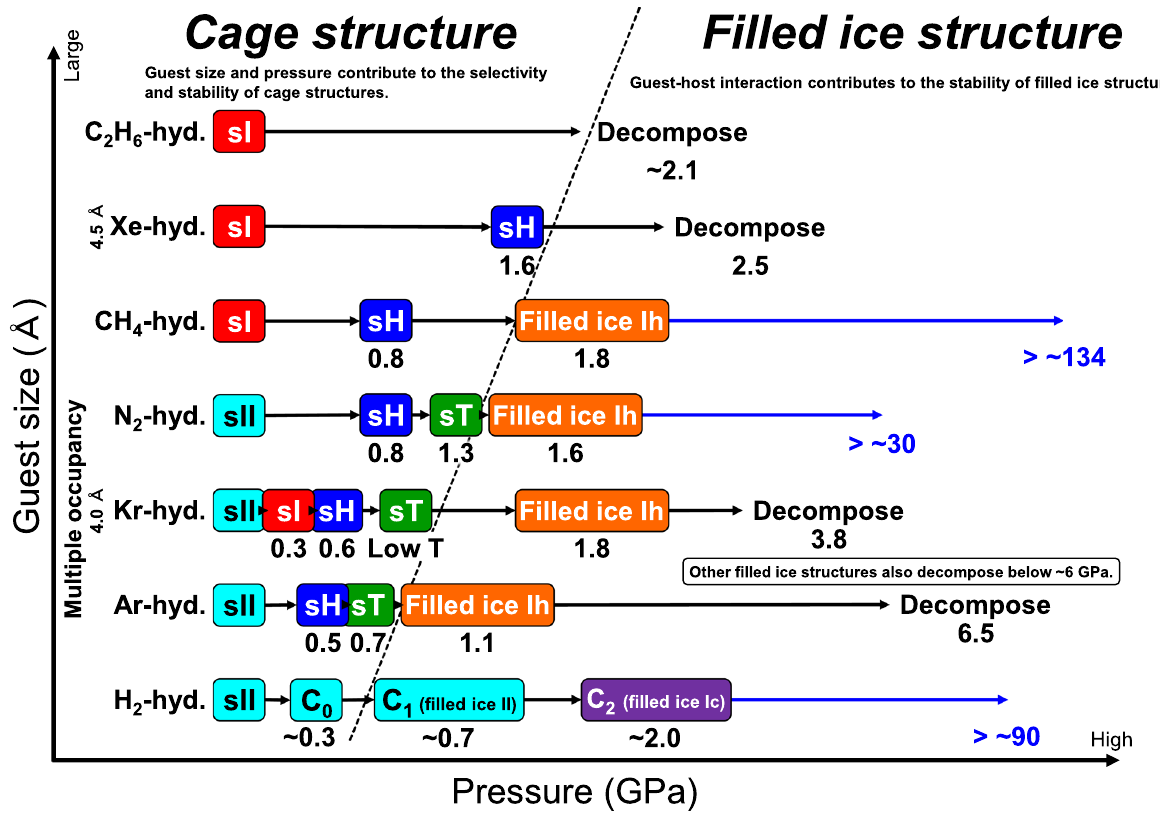
Fig. 1 General trends in the phase changes of gas hydrates as a function of pressure and guest size. The vertical axis indicates the guest size, with hydrogen being the smallest guest and ethane being the largest guest. Hydrates with guests larger than ethane have an initial sII structure, while extremely large guests result in an initial sH structure. The horizontal axis indicates pressure. Only MH and HH exhibit outstanding high-pressure